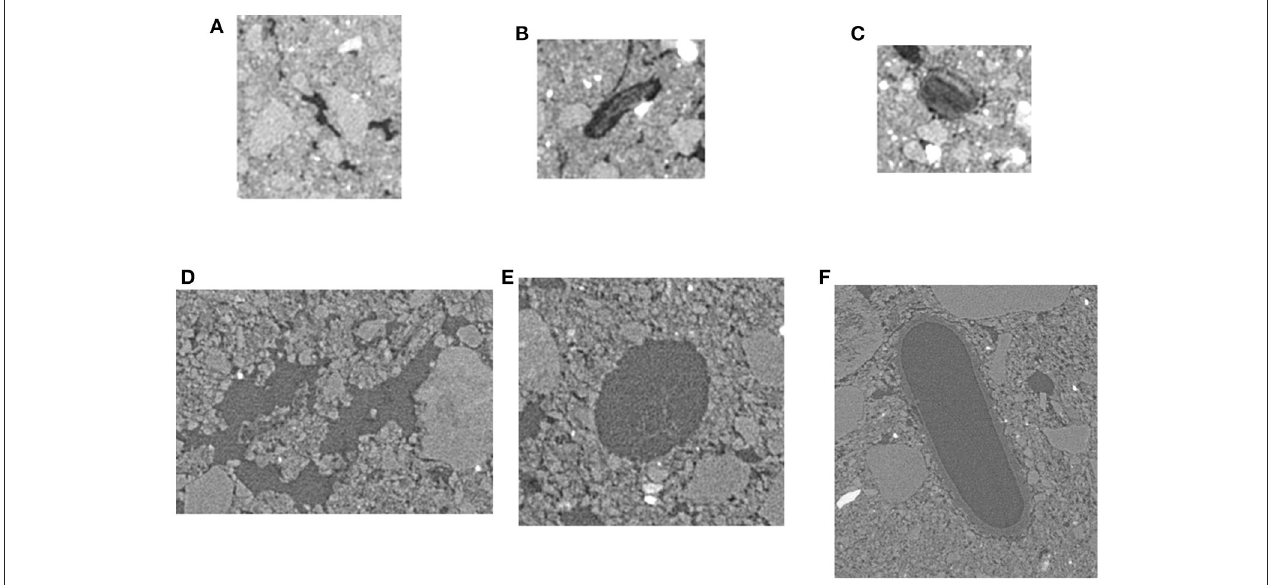
FIGURE 3 | Examples of selected non-biological (A,D) , POM-Root (B,E) , and POM-NS pores (C,F) for 13 and 2 µ m resolution. Non-biological pores were chosen so that no organic matter was visible in the pores and the pores were not round or oval in shape. POM-Root pores were chosen such that organic material was visible in the pores and were root shape, i.e., round or oval with an elongated shape. POM-NS was chosen such that organic material was visible within the pores and the pore did not have a root like